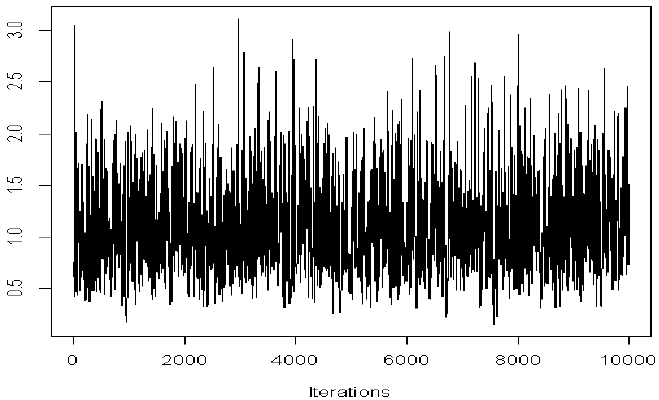
Figure 9. Density plot of τ 2 for the HBLD model using a log-logistic distribution.